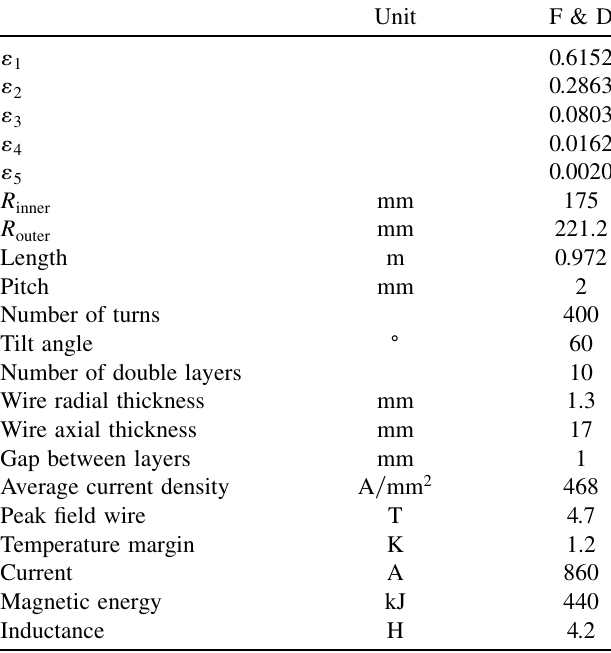
TABLE VII. Carbon magnet designs—offset solution.